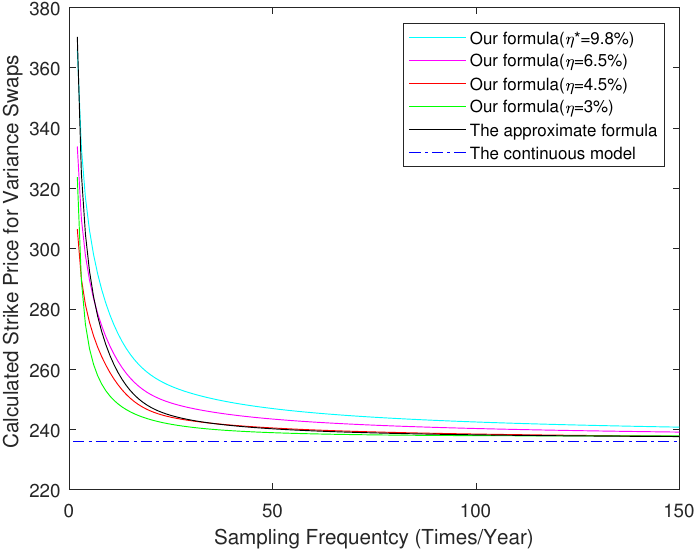
Figure 2. The values of variance swaps with different η in our hybrid